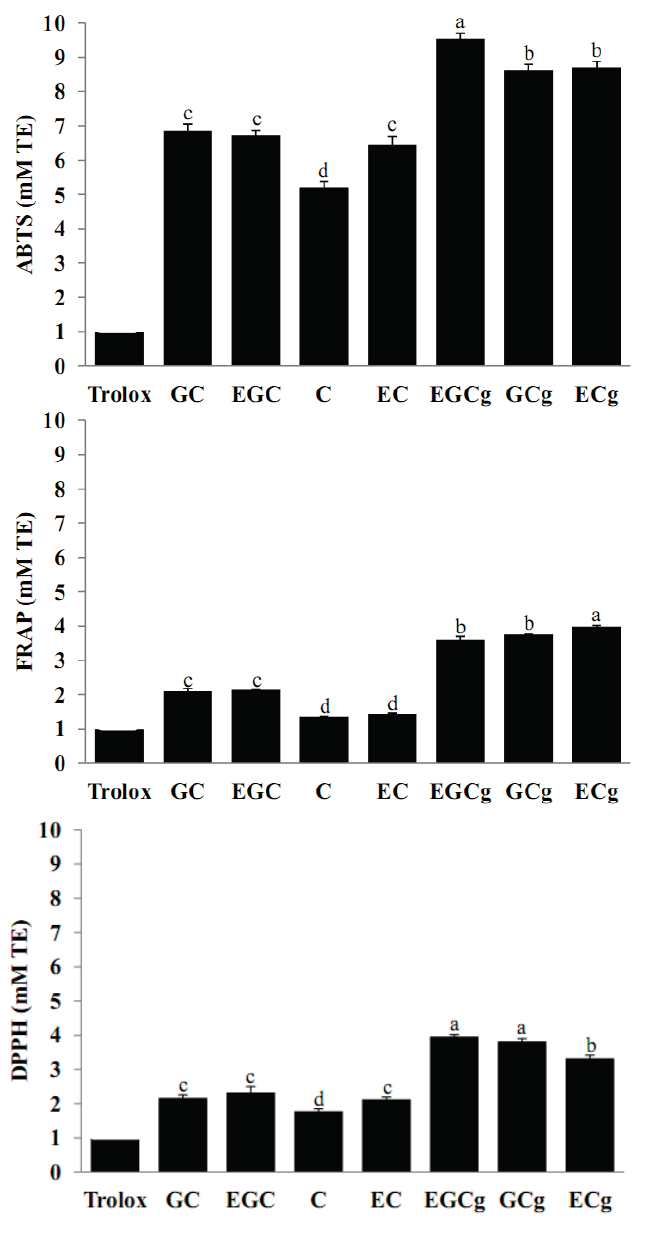
Figure 2. Antioxidant activity expressed as Trolox equivalent (mM TE) in standard catechins measured by ABTS, FRAP and DPPH assays. All values are mean ± SD. Values with different letters are significantly different by ANOVA with Tukey’s post hoc test at p < 0.05. GC, (+)-gallocatechin; EGC, ( − )-epigallocatechin; C, (+)-catechin; EC, ( − )-epicatechin; EGCg, ( − )-epigallocatechin gallate; GCg, (+)-gallocatechin gallate; ECg, ( − )-epicatechin